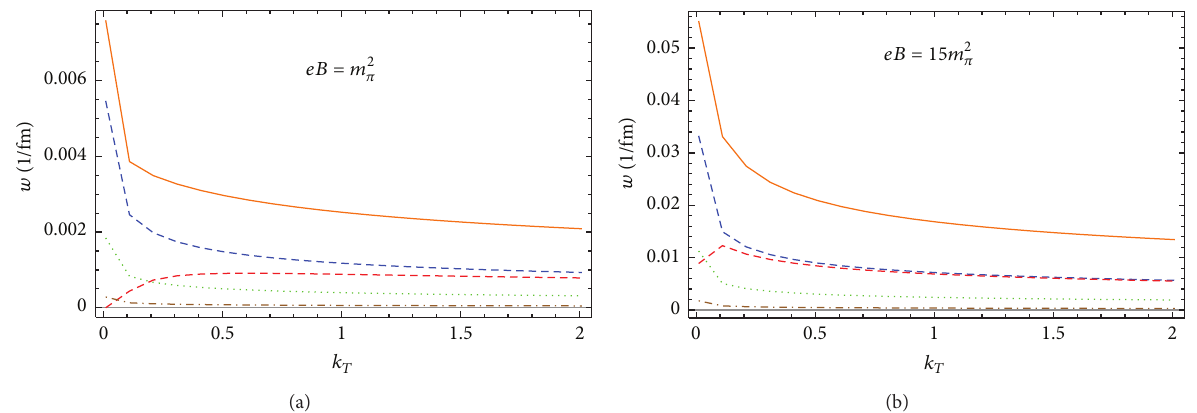
Figure 9: Decay rate of photons moving in reaction plane in magnetic field as a function of transverse momentum 𝑘 𝑇 : (a) at RHIC, (b) at LHC. Broken lines from bottom to top give contributions of 𝛾 → 𝑑𝑑, 𝛾 → 𝑢𝑢, 𝛾 → 𝜇 + 𝜇 − , and 𝛾 → 𝑒 + 𝑒 − channels. Upper solid line is the total rate.